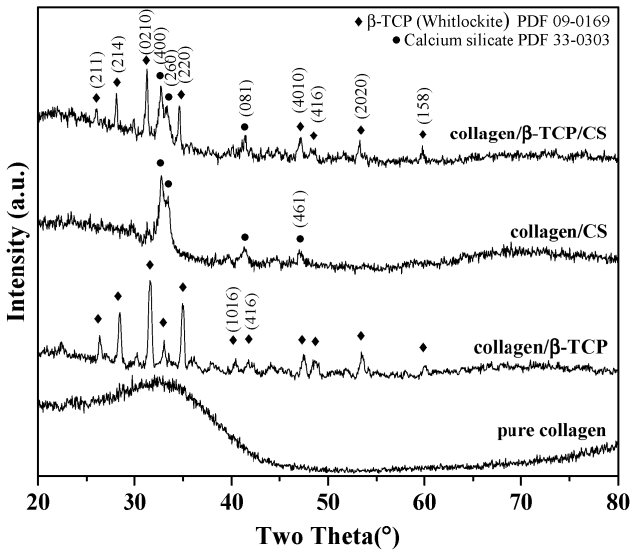
Figure 1. XRD patterns of pure collagen scaffold and collagen/ β -TCP, collagen/CS, and collagen/ β -TCP/CS composite scaffolds.